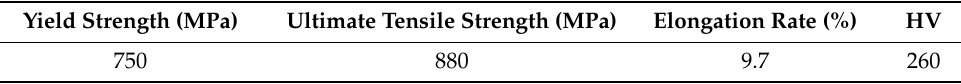
Table 2. The mechanical properties of 40Cr steel.